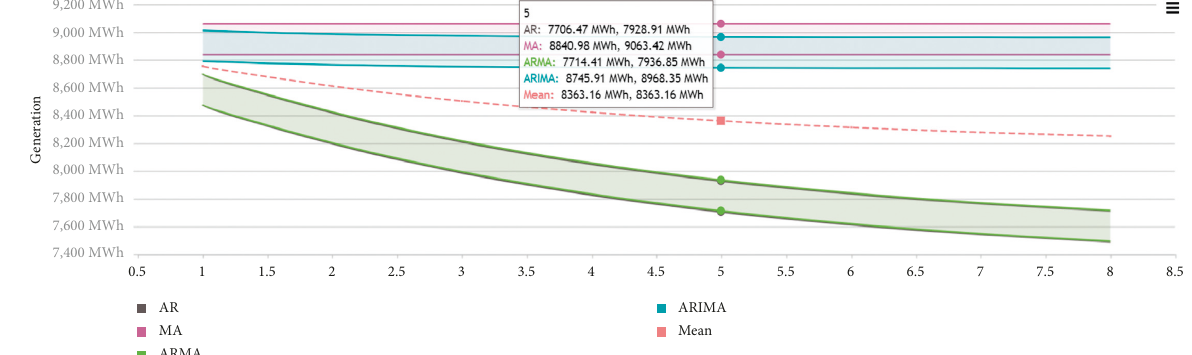
Figure 7: Interval plot for a long-term time horizon.